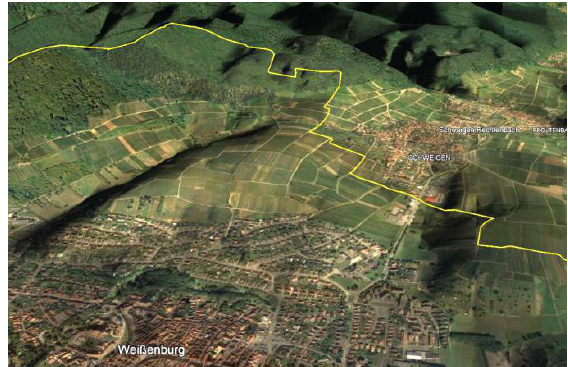
Figure 1. The research area north of Wissembourg done as a screenshot from Google earth. In the north is the village of Schweigen-Rechtenbach in Germany while in the south the city of Wissembourg is situated at the river Lauter in France. The border is marked in